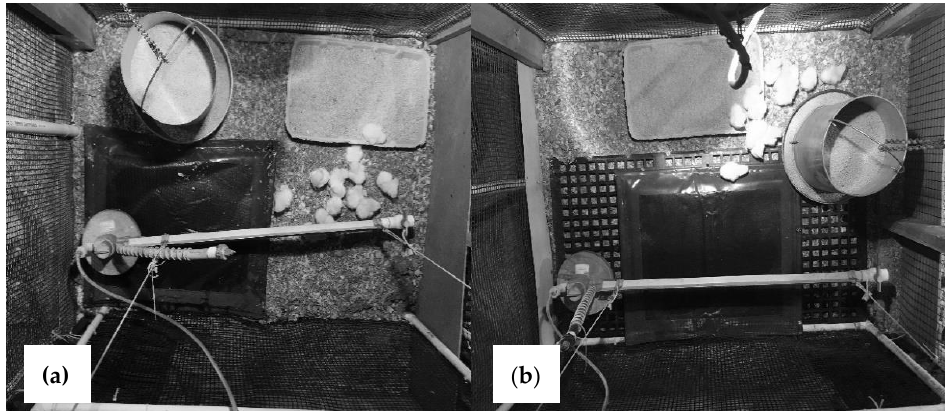
Figure 1. Top view photos of pen-based flooring treatments, with ( a ) a mat filled with 1% povidone- iodine solution (MAT) and ( b ) the iodine mat placed on a slatted floor (SLAT). The pens contained a hanging drinker line, a metal feeder, used litter, a disinfection mat, and for the SLAT treatment, a plastic slatted floor. In the first week, a feed flat with feed was provided. Fourteen video cameras (IP Bullet camera FLPB133F, FLIR Systems Inc., Wilsonville,